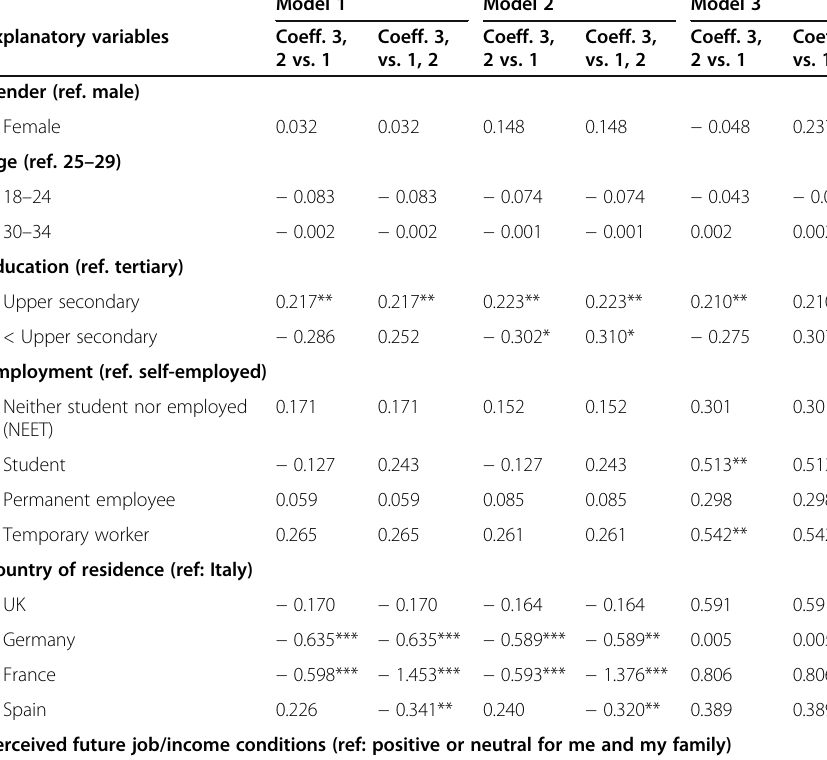
Table 4 Results of generalized ordered logistic regression for the determinants of the decision of postponing or abandoning the plan of going to live on their own